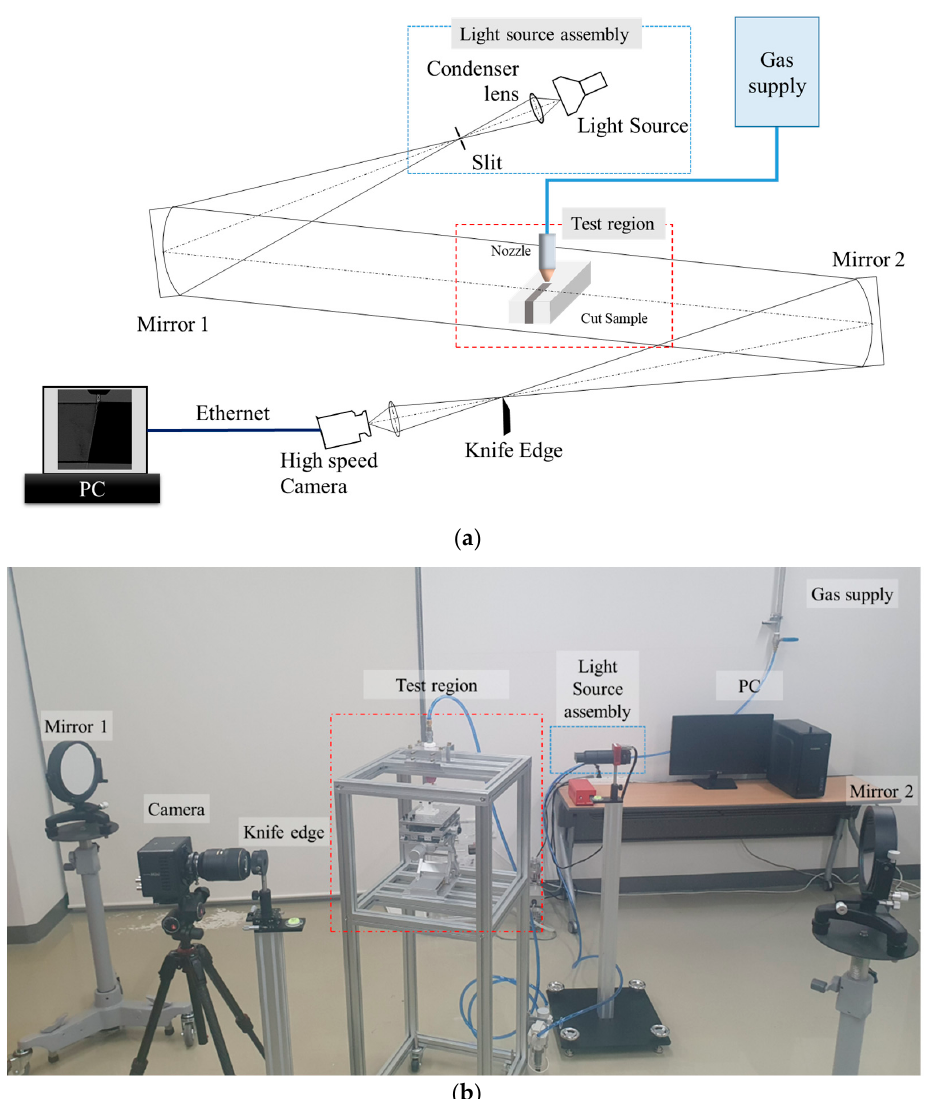
Figure 3. Schlieren experiment: ( a ) Schematic diagram of Schlieren method. ( b ) Experimental setup for Schlieren method.